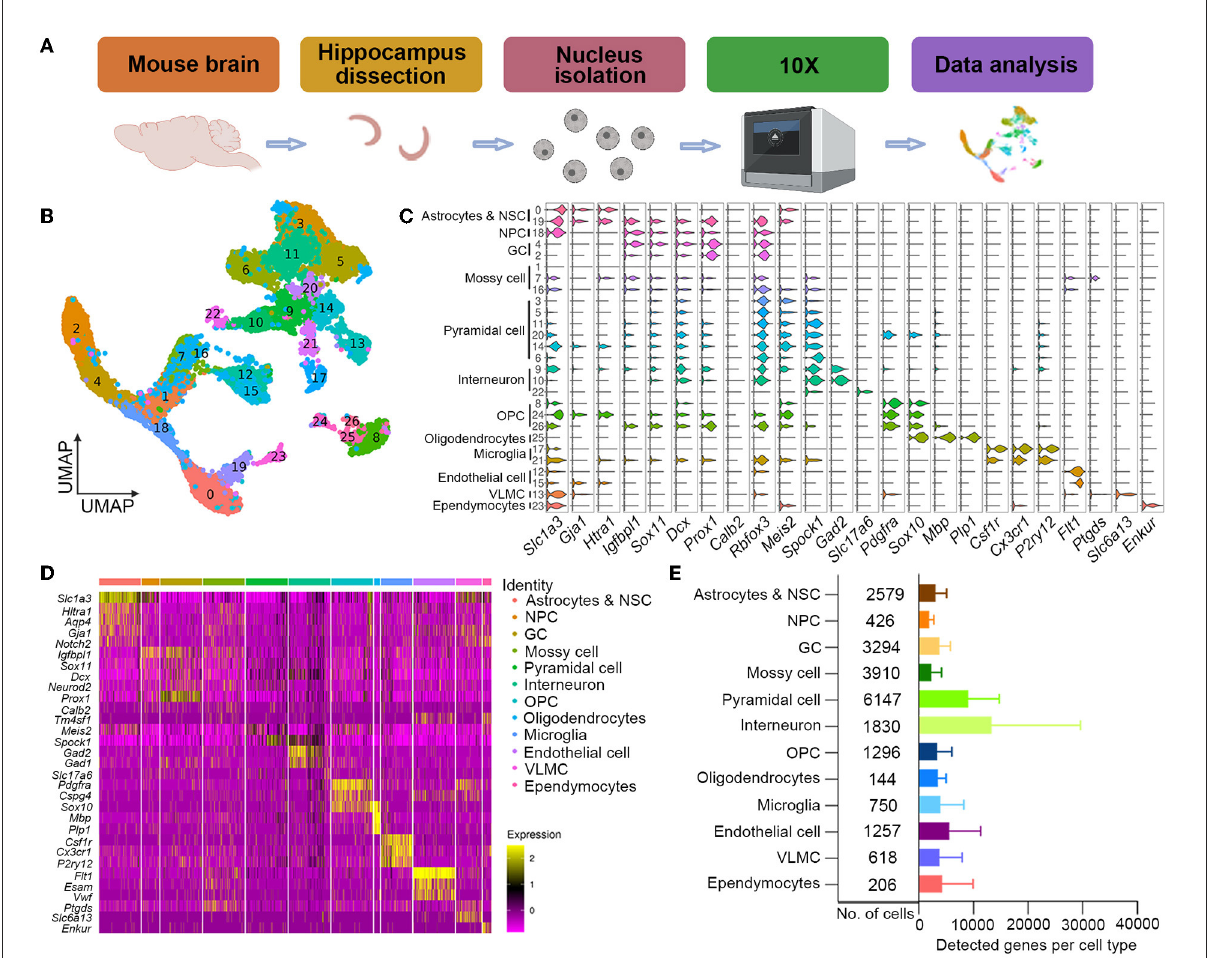
FIGURE3 Single-nuclei cell transcriptome atlas of hippocampal neurogenesis after low-dose Propofol exposure. (A) Schematics of single-nuclei RNA sequence experiment and data analysis. (B) UMAP visualization integrating 22,457 high-quality single cells from hippocampus samples at PND 10 after exposure, colored by cluster annotation. (C) Violin plot showing the distribution of expression levels of representative cell-type-enriched marker genes across 12 cell types. The x-axis indicates the normalized expression levels of the corresponding marker genes. (D) Heatmap of all single cells ordered by UMAP clusters. Columns, individual cells. Rows, genes. Boxed areas, gene expression modules. (E) Bar plot showing the total number of detected cells and the average number of detected genes per cell type. Error bars, mean ±